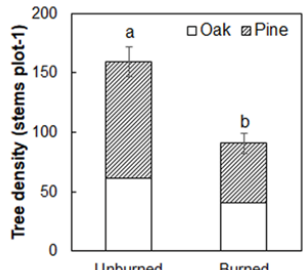
Figure 6. Differences in tree density between the unburned and burned plots. Different letters indicate significant differences between treatments at p < 0.05. Values are presented as the means ± standard error.